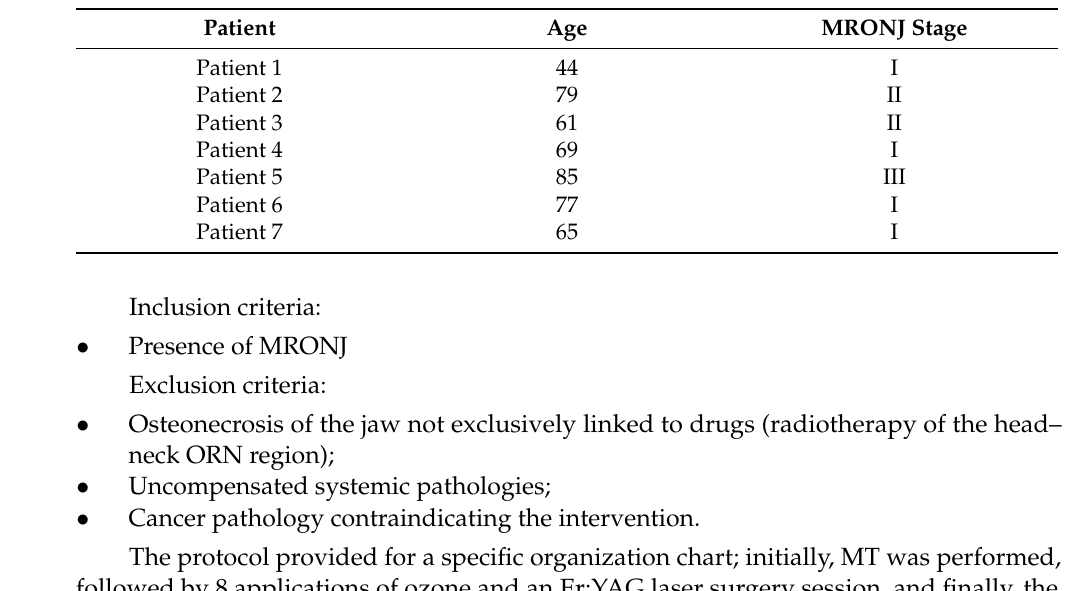
Table 2. Group 5 patients’ demographic and clinical